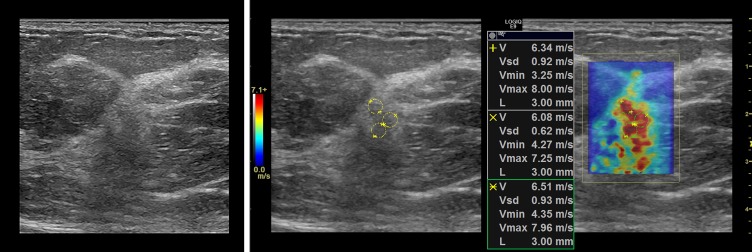
Shear wave map of a 1.4cm malignant mass diagnosed as invasive ductal carcinoma, grade III. Emean = 117.8kPa.